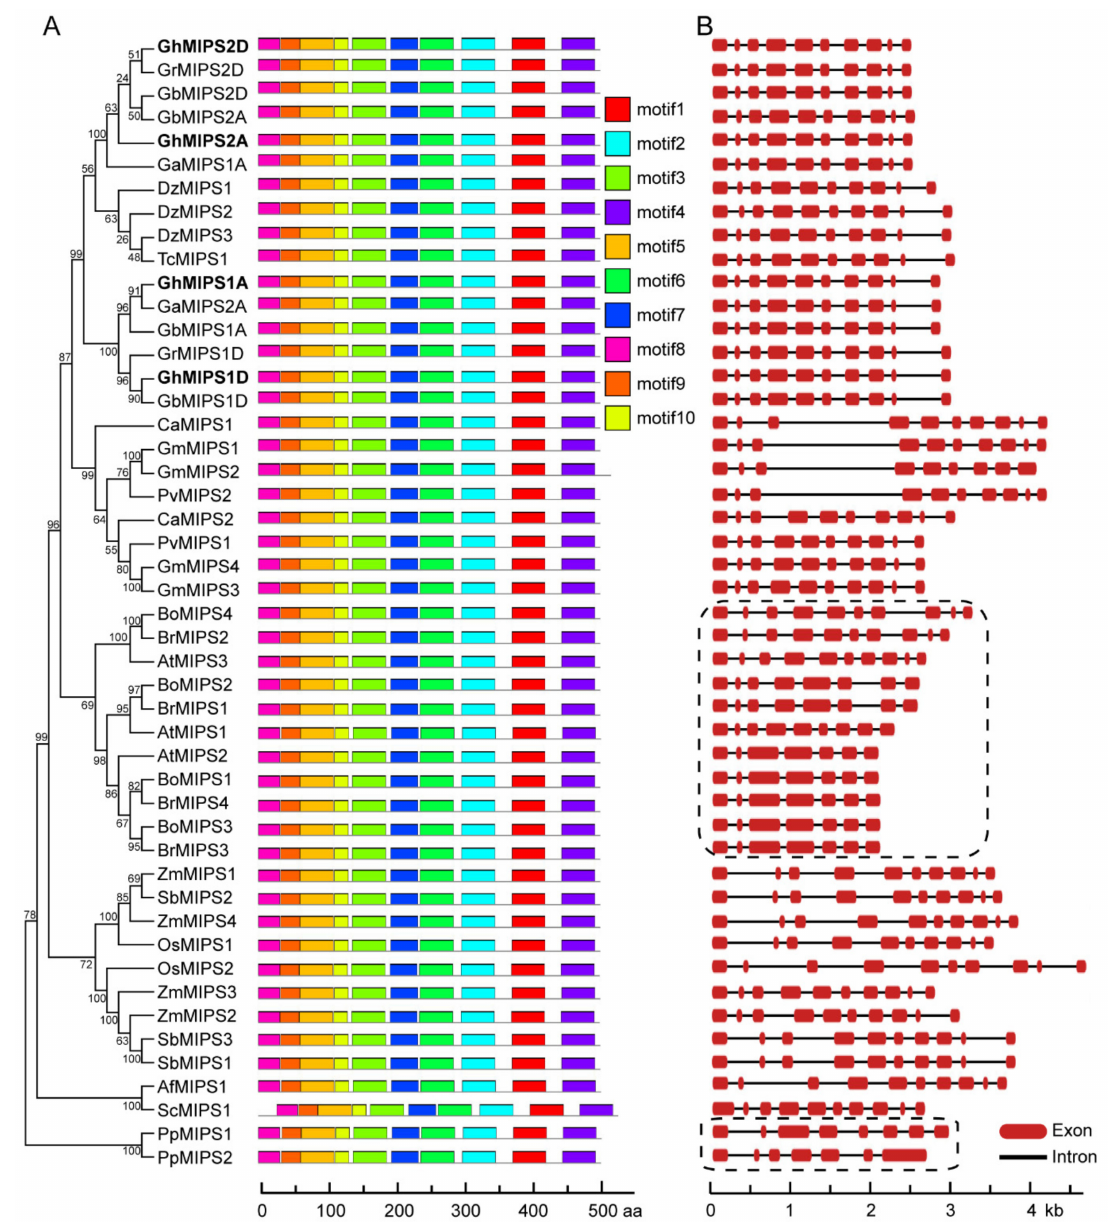
Figure 3. Conserved motif and exon-intron dynamic analyses of 48 plant MIPS genes. ( A ) Conserved motifs of protein sequences of 48 plant MIPS proteins. Ten conserved motifs were recognized and represented in different colors. All MIPS proteins are arranged according to their phylogenetic relationships. ( B ) The exon-intron structures of 48 plant MIPS genes. Two frames represent Bryophytes plants ( Physcomitrella patens , seven and eight exons) and Brassicales plants (from seven to ten exons), which possess usual exon-intron structures. The detailed information for organism names, protein sequences and accession numbers are available in Supplementary Table